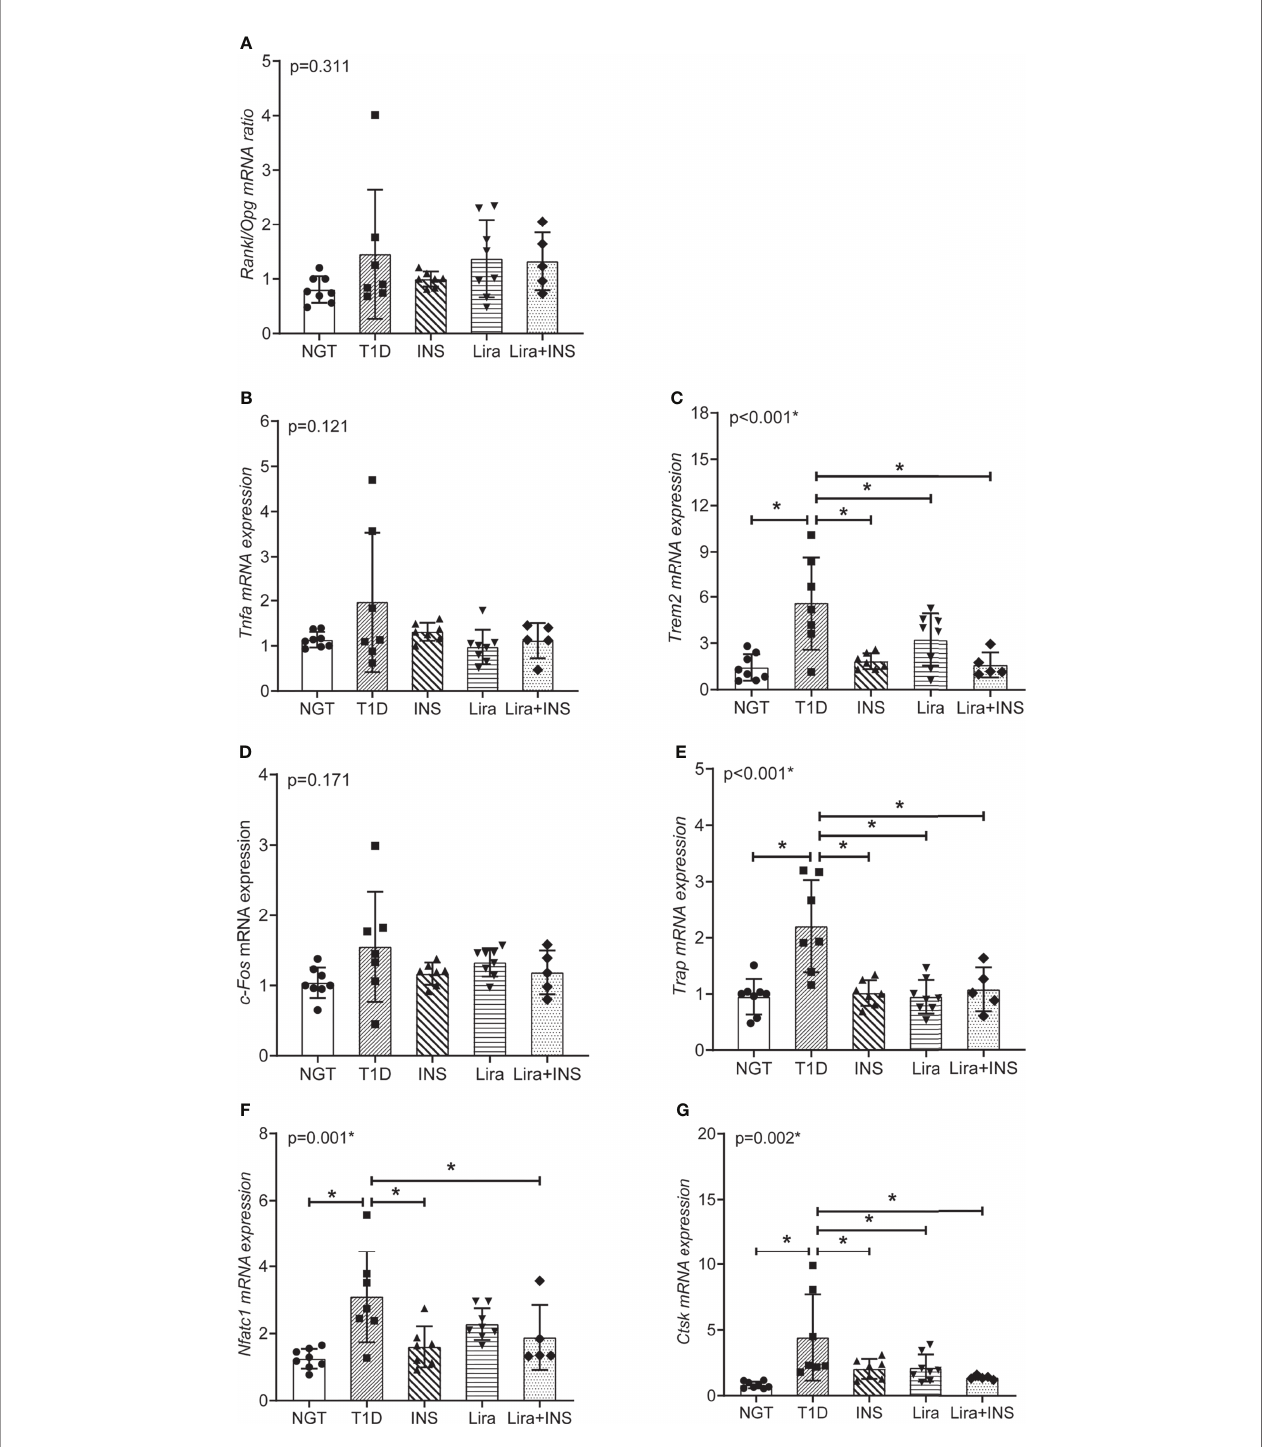
FIGURE 8 | Relative mRNA expression in the signaling pathways of osteoclastogenesis and TNFa in fl ammation in tibia tissues. (A) The ratio of Rankl / Opg mRNA expression; (B) Tnfa mRNA expression; (C) Trem2 mRNA expression; (D) c-Fos mRNA expression; (E) Trap mRNA expression; (F) Nfatc1 mRNA expression; (G) Ctsk mRNA expression. NGT, normal glucose tolerance group; T1D, type 1 diabetes group; Lira, liraglutide treatment group; INS+Lira, insulin + liraglutide treatment group. ANOVA was used for comparison between groups, and p < 0.05 was de fi ned as statistically signi fi cant. * was used to indicate statistical difference. All data are expressed as mean ±